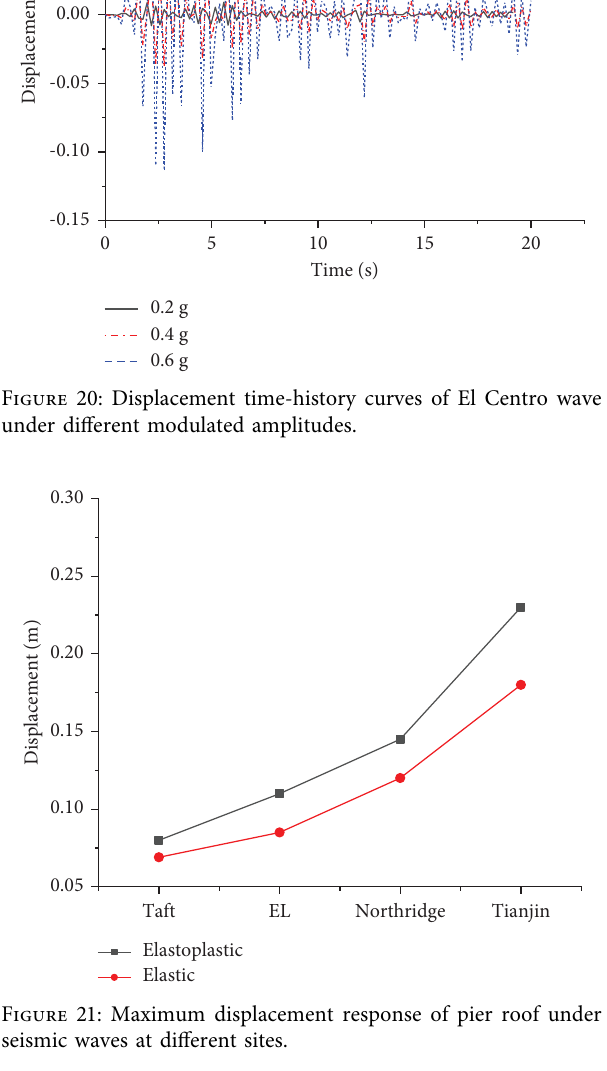
Figure 19: Displacement time-history curves of Taft wave under diferent modulated amplitudes.